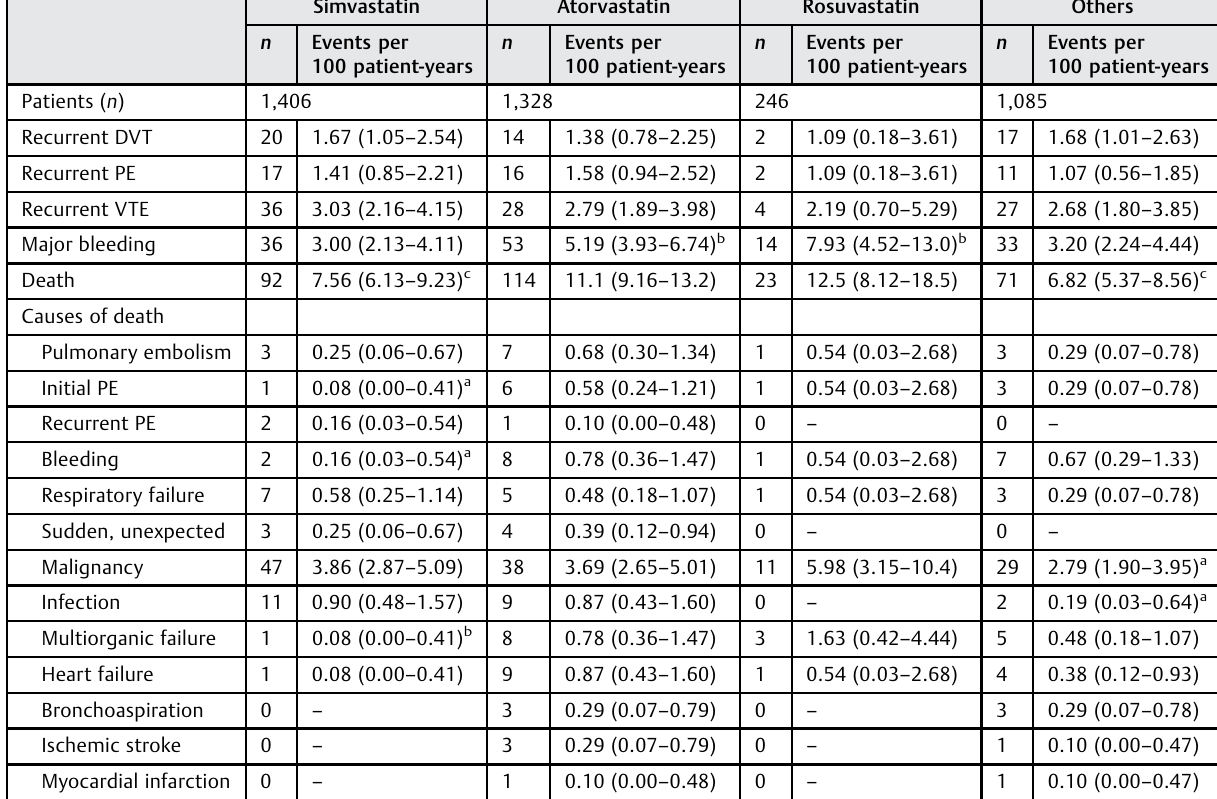
Table 4 Clinical outcomes during anticoagulation, according to the type of statin